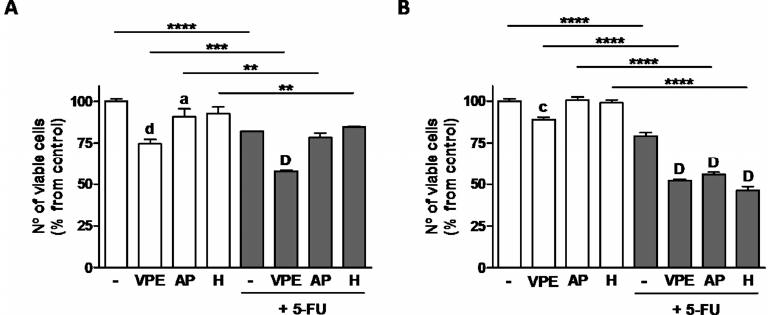
Figure 4. Effect of 48 h exposure to VPE, apigenin (AP), and hesperidin (H), alone and in combination with 5-FU on cell viability of HCT116 ( A ) and RKO ( B ) cells, as measured by the MTT assay. Cells were pre-incubated with the VPE (IC 25 ) and corresponding concentrations of AP, or H (see Table 3) for 48, followed by co-incubation with 5-FU (IC 25 ) for a further 48 h ( A & B ). Cells that were not pre-treated were only exposed to 5-FU for 48 h. Values are expressed as mean ± SEM of three independent experiments. Letters and symbols represent statistical significance: a p ≤ 0.05, c p ≤ 0.001, d p ≤ 0.0001 when compared with control; D p ≤ 0.0001 when compared with 5-FU; ** p ≤ 0.01, *** p > 0.001, **** p ≤ 0.0001 when compared with respective extract / compound by two-way